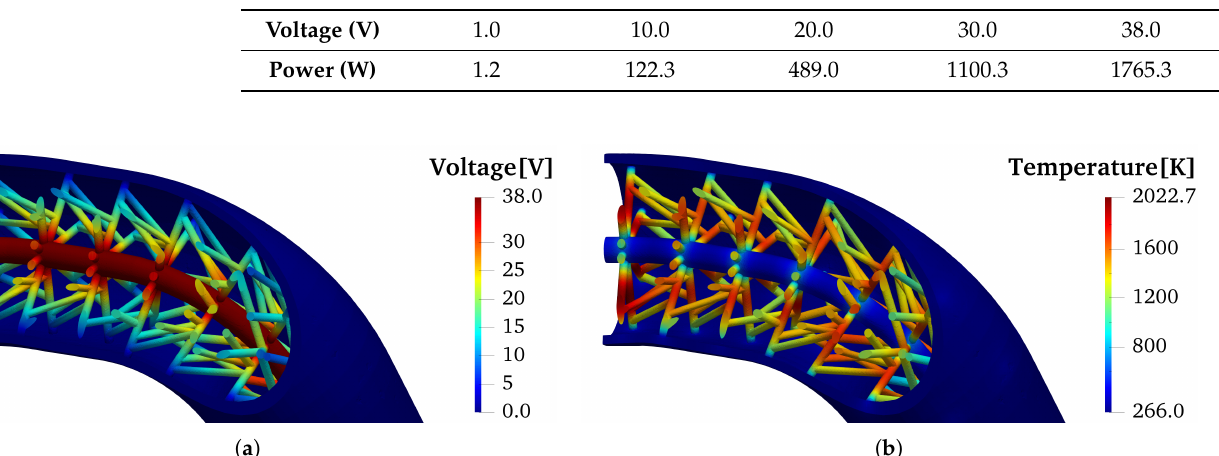
Figure 11. Electrical heating sensitivity analysis: qualitative estimation of the computational grid ef- fects. ( a ) Voltage distribution; and ( b ) temperature